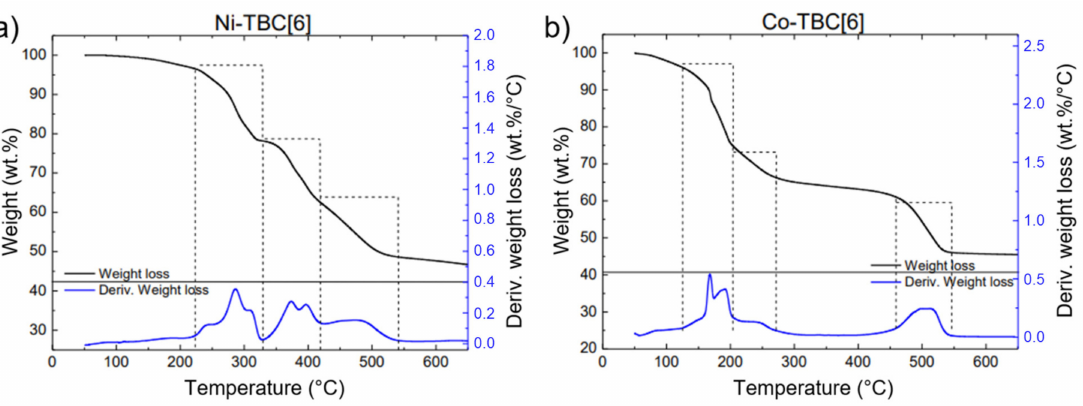
Figure 3. Thermogravimetric (TG) and differential thermogravimetric (DTG) profiles of ( a ) Ni-TBC[6] and ( b )